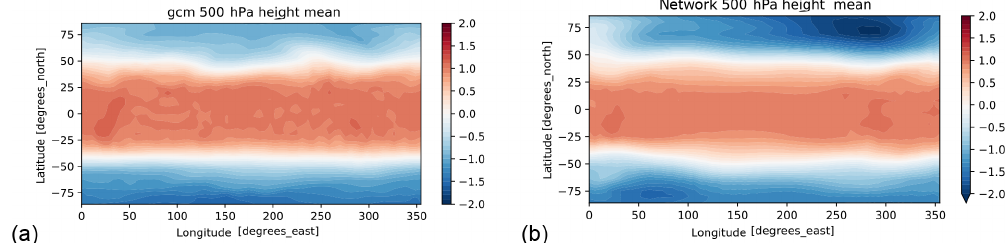
Figure 7. Thirty-year mean of normalized 500hPa geopotential height for plasimt21 (a) and the network trained on 100 years of plasimt21 (b)